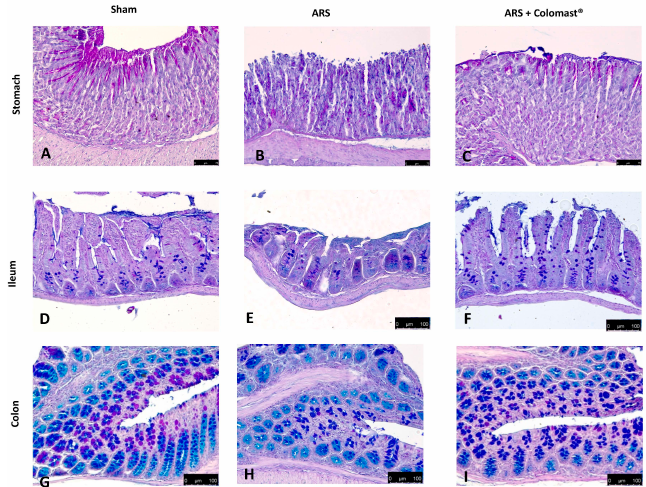
Figure 3. Effect of Colomast ® pre-treatment on alteration of mucous secreting cells. Alcian blue/PAS staining in stomach section: sham ( A ), ARS ( B ), Colomast ® ( C ); in ileum section: sham ( D ), ARS ( E ), Colomast ® ( F ); in colon section: sham ( G ), ARS ( H ), Colomast ® ( I ). Images are figurative of at least three independent experiments. Values shown are means ± SEM of six animals in each group. For Alcian blue/PAS staining, a 40× magnification is shown (75-µm scale bar) for stomach; a 20× magnification is shown (100-µm scale bar) for ileum and colon.